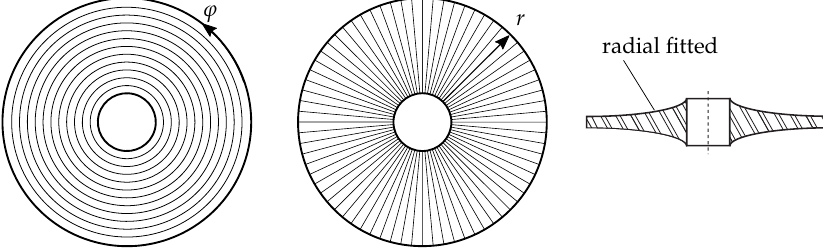
Figure 9. Fibre alignment of the two sub-preform types and rotor thickness